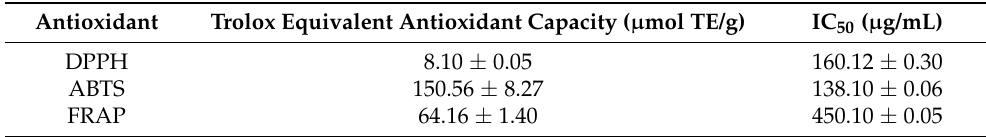
Values are expressed as mean ± standard deviation of three